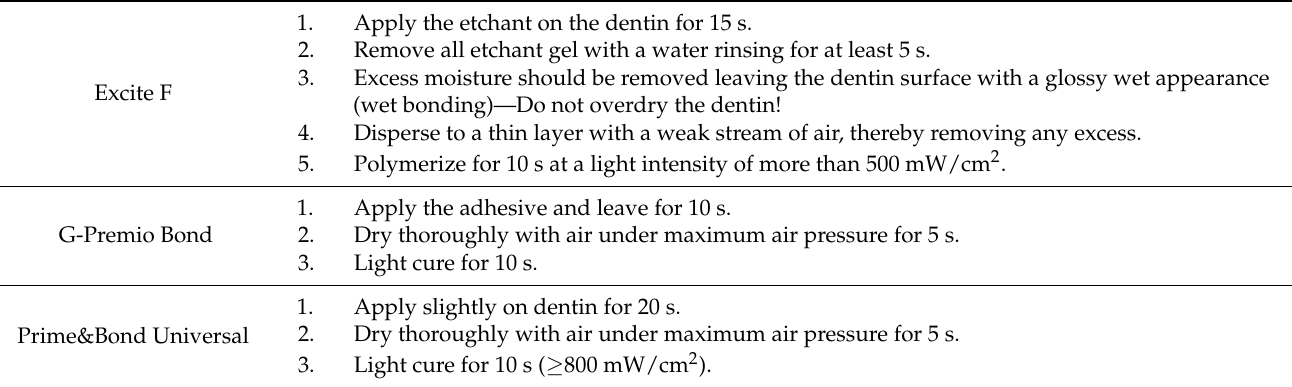
Table 2. Manufacturers’